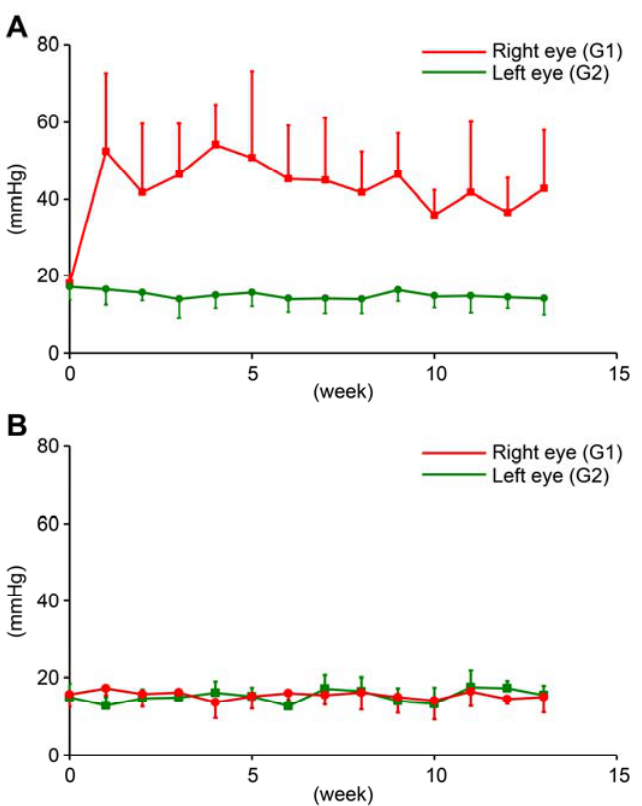
Figure 1. Intraocular pressure (IOP) of ocular hypertension (OH) eyes (G1), contralateral untreated eyes of OH ferret (G2), and normal eyes of control ferret (G3). ( A ): Red line indicates IOP of right OH eyes, and green line indicates IOP of contralateral left untreated eyes in OH ferret (mean ± S.D.). ( B ): Red and green line indicate IOP of right and left eyes in control ferret (mean ± S.D.).